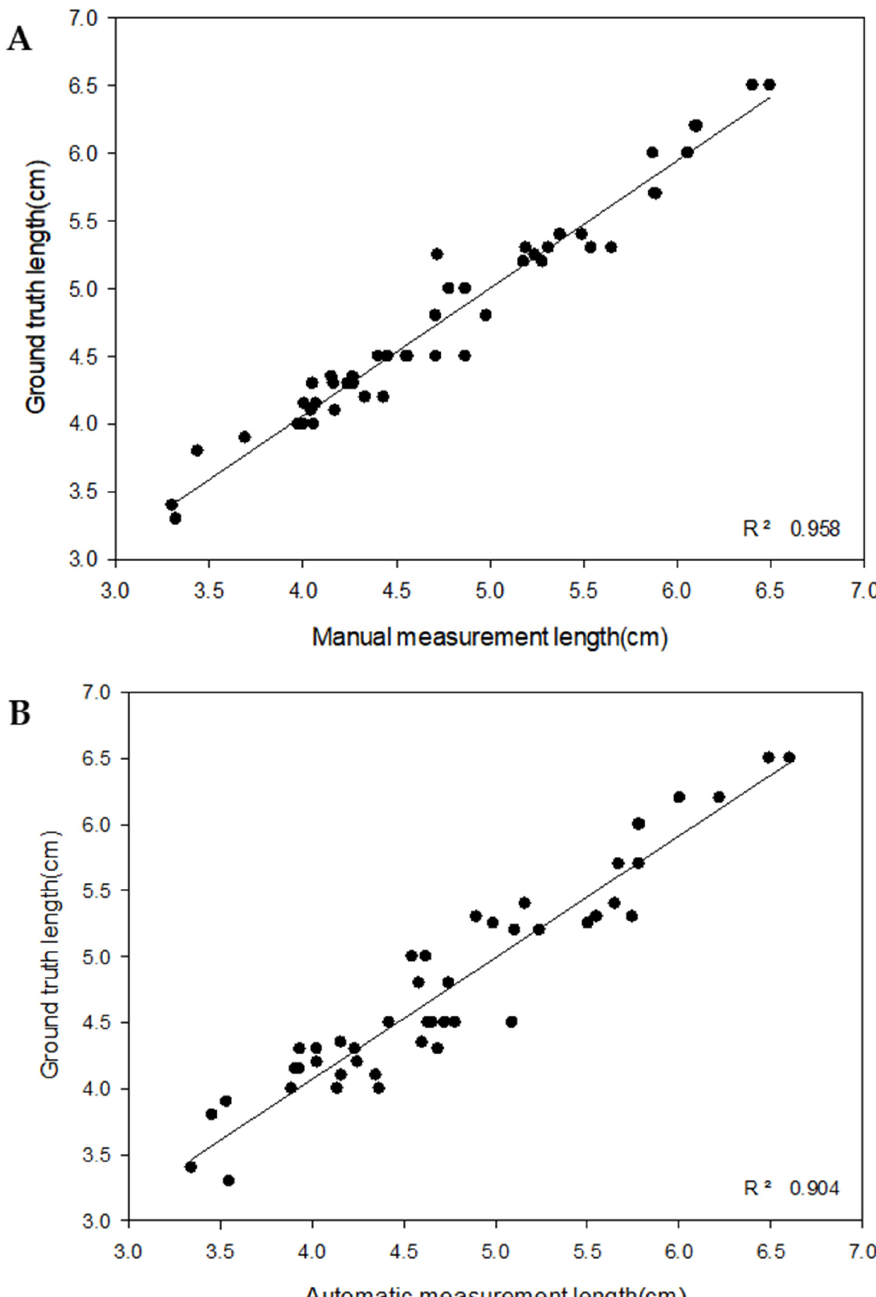
Figure 15. Comparison of automatically measured leaf length with ground truth data: ( A ) manual measurement and ( B ) segmentation and automatic measurement.